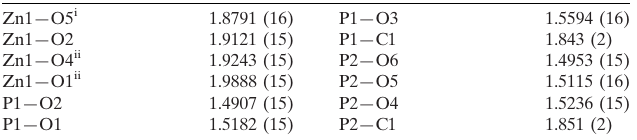
Selected bond lengths (A˚ ).